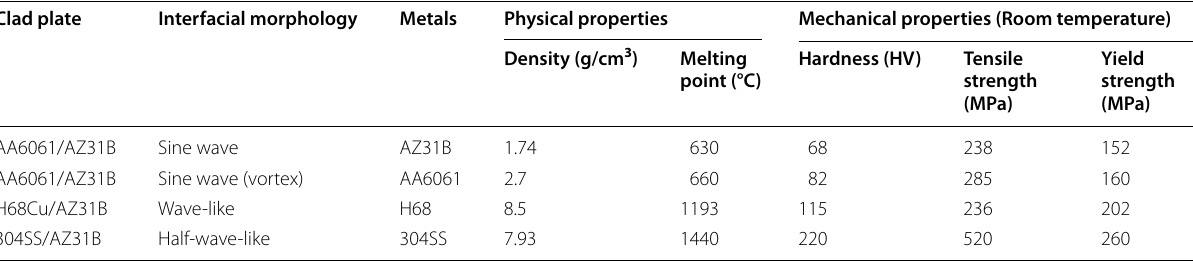
Table 2 Interfacial morphologies and experimental physical and mechanical properties of Al/Mg, Cu/Mg and SS/Mg explosive welds